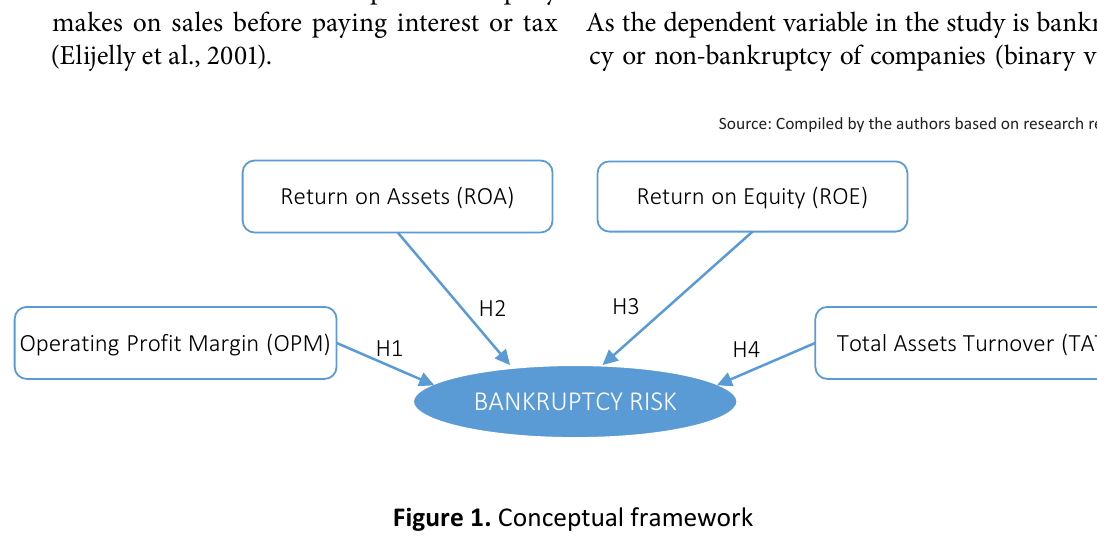
Figure 1. Conceptual